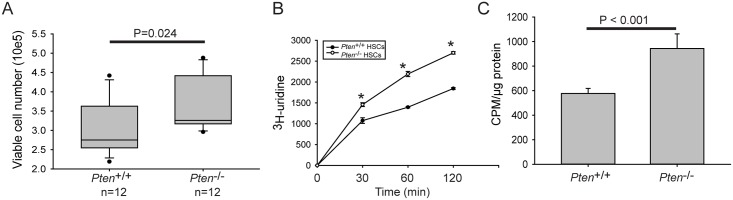
Proliferation, rRNA production, and protein synthesis are robust in Pten-/- HSCs.(A). To measure proliferation, HSCs were plated in 100 μl fresh medium, and cultured for 5 days. The viable cell number was measured based on total cell number and trypan blue staining. Data shown was derived from 12 clones derived from two age matched female mice of each genotype. (B). HSCs were pulse labeled with 3H-uridine for the time indicated. RNA was isolated with TriZol reagent. 1 μg of total RNA was counted in a Beckman LS 6500 multipurpose scintillation counter to determine new rRNA production. Three clones were labeled to derive the standard deviation from two pairs of mice of each genotype from the same litter. Significance was calculated using an unpaired t test, the asterisk indicates p<0.05. (C). To measure global protein synthesis, HSCs were pre-cultured in medium lacking methionine, and pre-treated with 10 μM MG-132, a proteasome inhibitor, for 1 hour. HSCs were incubated with 30 μCi of 35S-methionine for 1 hour. Incorporation of 35S-methionine into proteins was quantified in a liquid scintillation counter. Clones were derived from two mice of each genotype, with three replicates per genotype. A t test was performed for statistical significance.